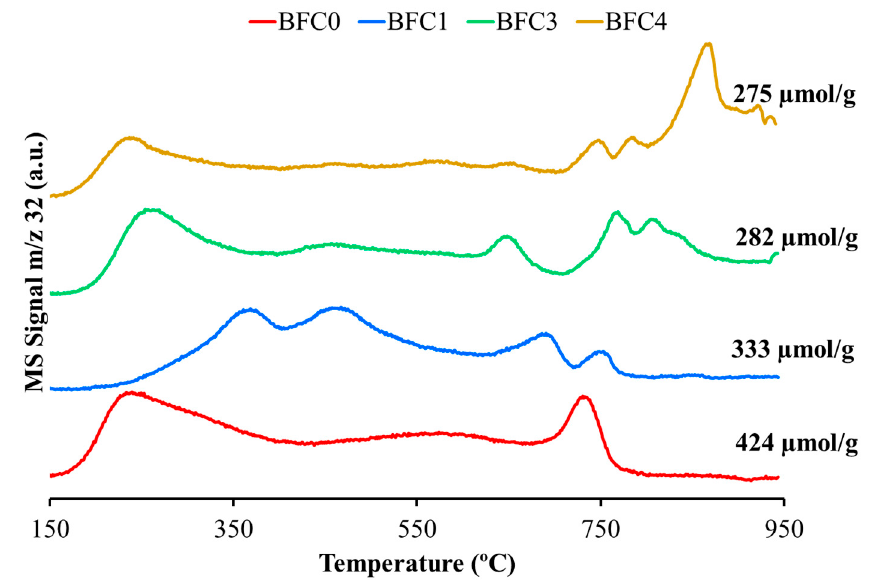
Figure 8. O 2 -TPD profiles for BaFe 1 − x Cu x O 3 catalysts.